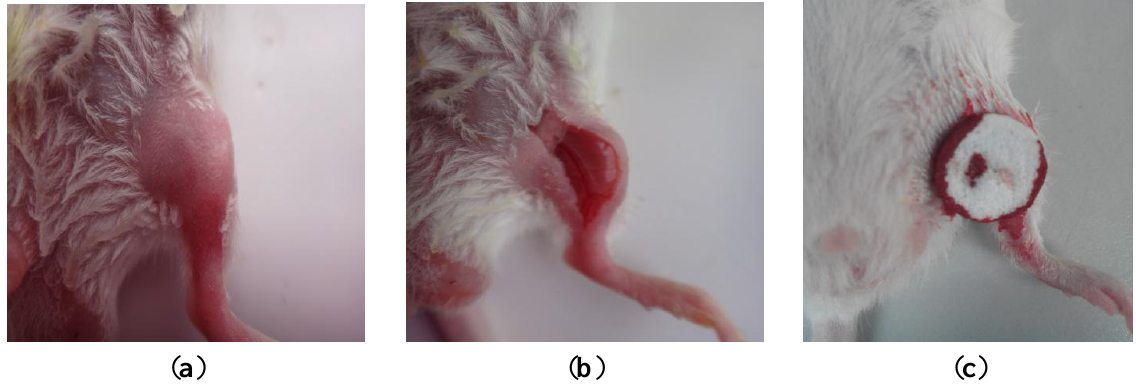
Figure 8. Photographs of ( a ) mouse leg after removing the hair; ( b ) trauma model on femoral artery of mouse; and ( c ) the hemostatic effect of sponge on mouse.